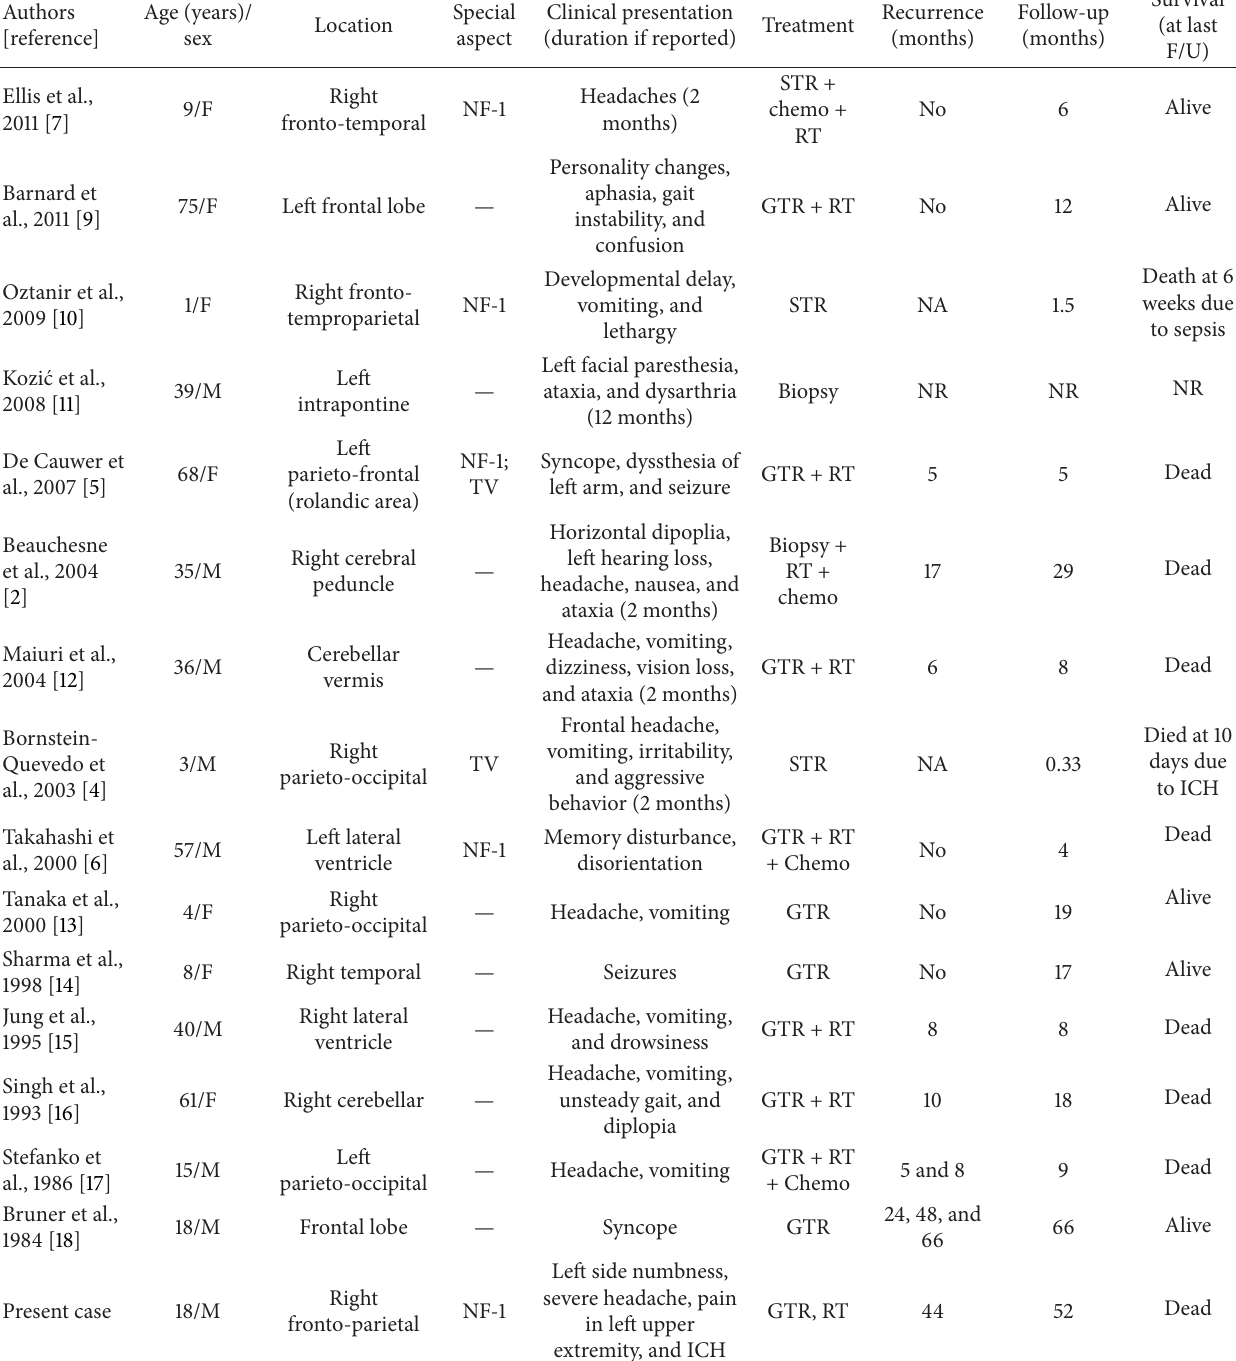
Table 1: Clinical findings and outcomes in 15 previously reported cases of